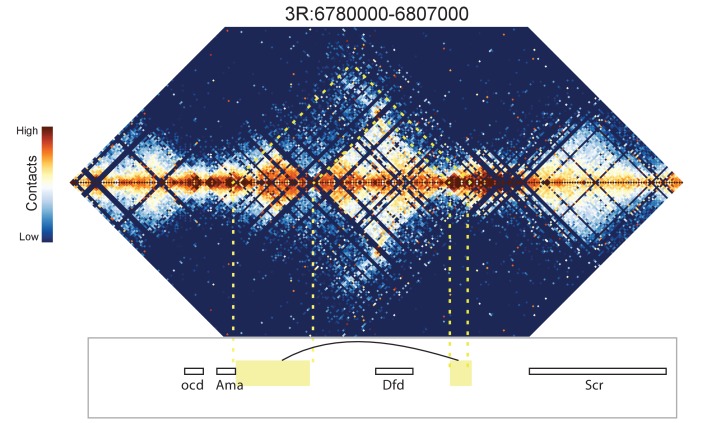
Distal chromatin contacts in stage 55 embryos.Hi-C maps prepared as in Figure 8 for manually-curated distal interactions. Data shown at 500 bp resolution, all nc14 data aggregated. Gene tracks are from the UCSC genome browser and shown with dm6 coordinates. A complete list of observed distal interactions is available in Supplementary file 1, along with dm3 coordinates.